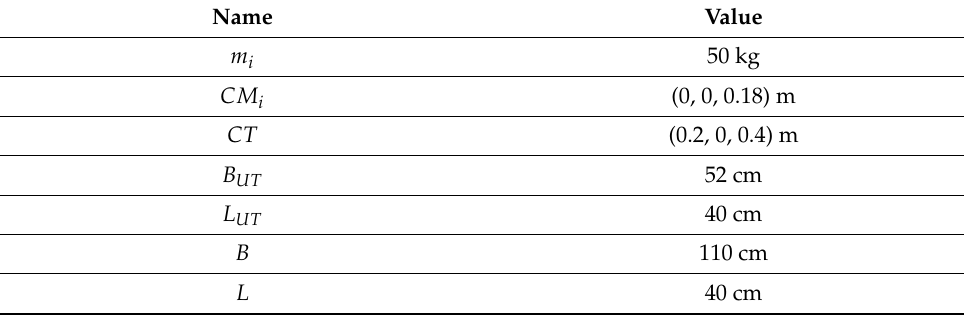
Figure 19. Test trajectory ( left ) and x-axis motion of the AGV without trailers ( right ). Table 3. AGV system parameters.